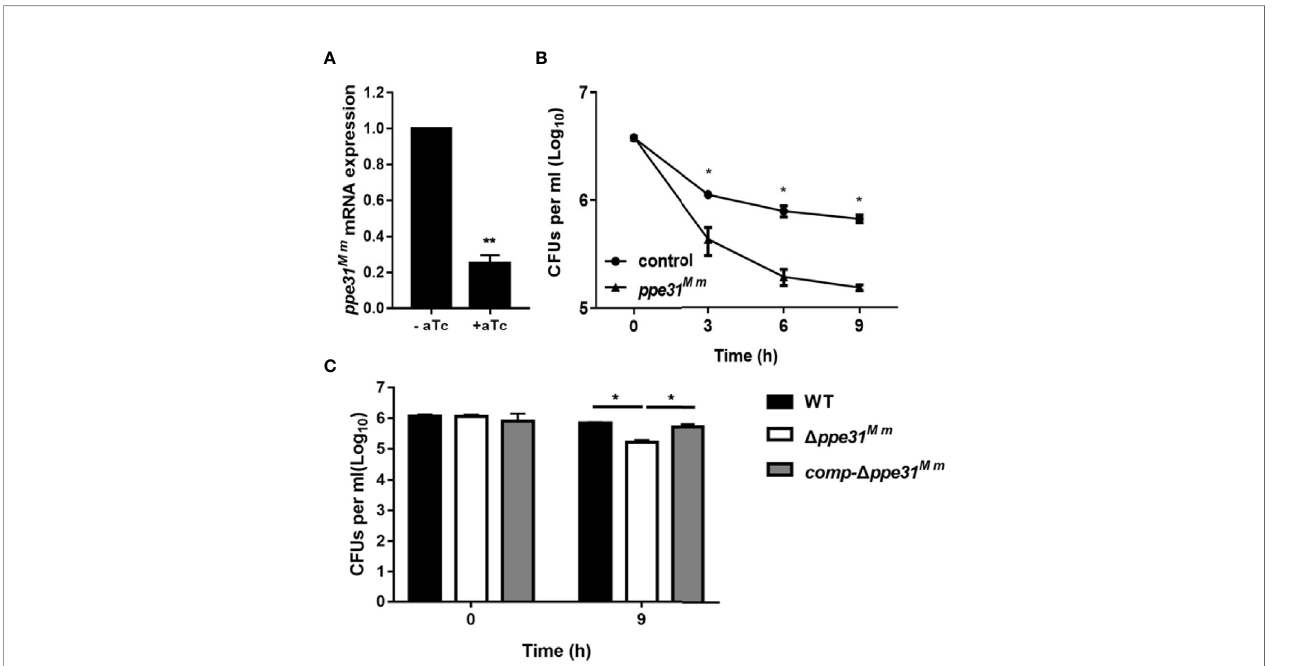
FIGURE 1 | PPE31 Mm was required for the resistance of M. marinum to acid medium in vitro . (A) CRISPR interference has been performed for knockdown of ppe31 Mm . Expression of ppe31 Mm determined by RT-qPCR with or without induction of aTc. (B) M. marinum contain dCas9 and sgRNA targeting ppe31 Mm were exposed to 7H9 medium of pH4.5 with or without (control) induction of aTc. The bacterial survival was monitored by CFU counting at the indicated time. (C) WT, D ppe31 Mm , or comp- D ppe31 Mm were exposed to 7H9 medium of pH4.5 at 30°C. The bacterial survival was monitored by CFU counting for 9h. Data are shown as mean±S.E.M. of three independent experiments. * p < 0.05, ** p <